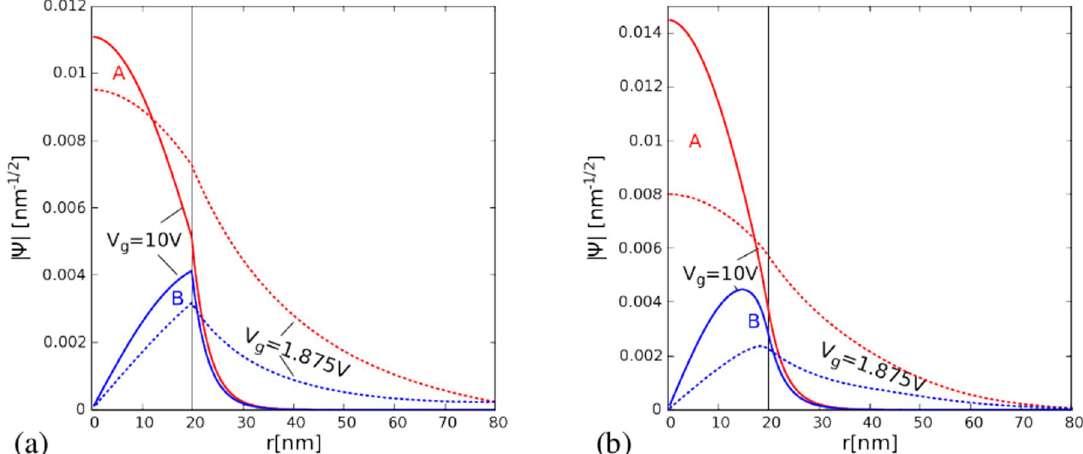
Figure 5. Absolute value of the radial functions for the K ′ , j ′ = − 1/2 state at 0.5 T for V g = 10 V (solid lines) and V g = 1.875 V (dashed lines) for the continuum Hamiltonian. The A (B) sublattice component is plotted with the red (blue) line. The vertical solid line indicates the radius of the quantum well R = 20 nm defined within the 2 2 . The infinite mass boundary flake of 80 nm. The applied normalization condition is ∫ Ψ Ψ | | + | | = r dr ( ) 1 A B conditions are applied at the end of the flake at r = R ′ = 80 nm. Panel (a) shows the results for the rectangular potential well [Eq. (1)] and (b) for the smooth electrostatic potential of Fig.